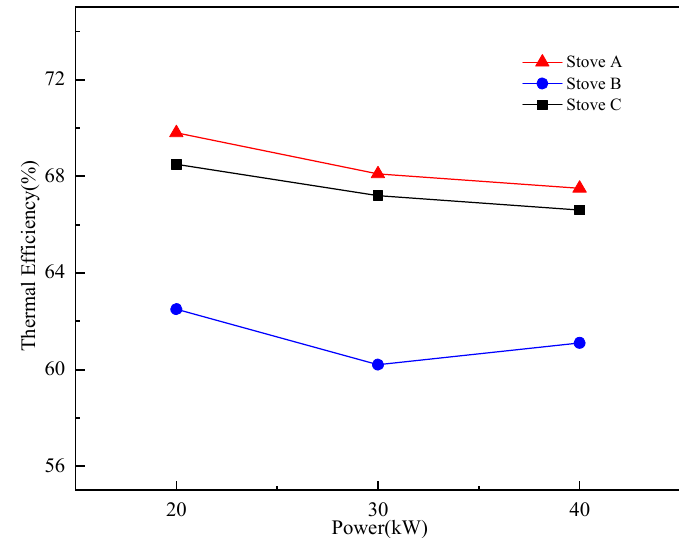
Figure 6. Thermal efficiency of the three stoves at different powers.